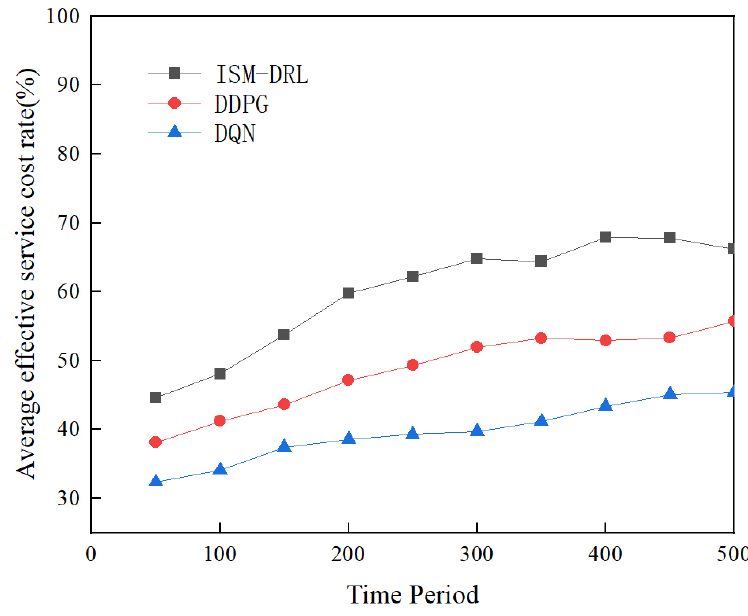
Figure 3. Average effective service cost rate at α 1 = 0.3, α 2 = 0.7.